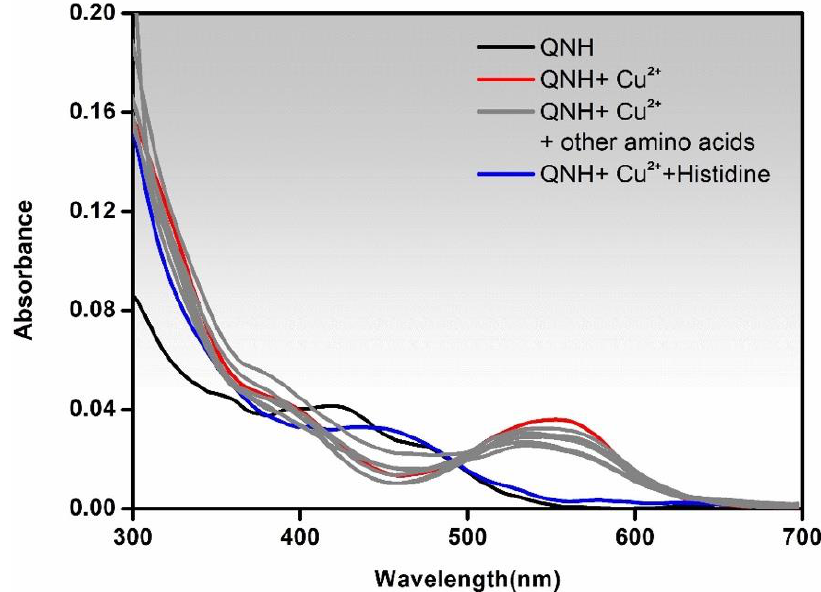
Figure 4. Absorption spectrum of QNH – Cu 2+ complex in the presence of different amino acids in (3:7 v / v ) HEPES buffer: acetonitrile medium.